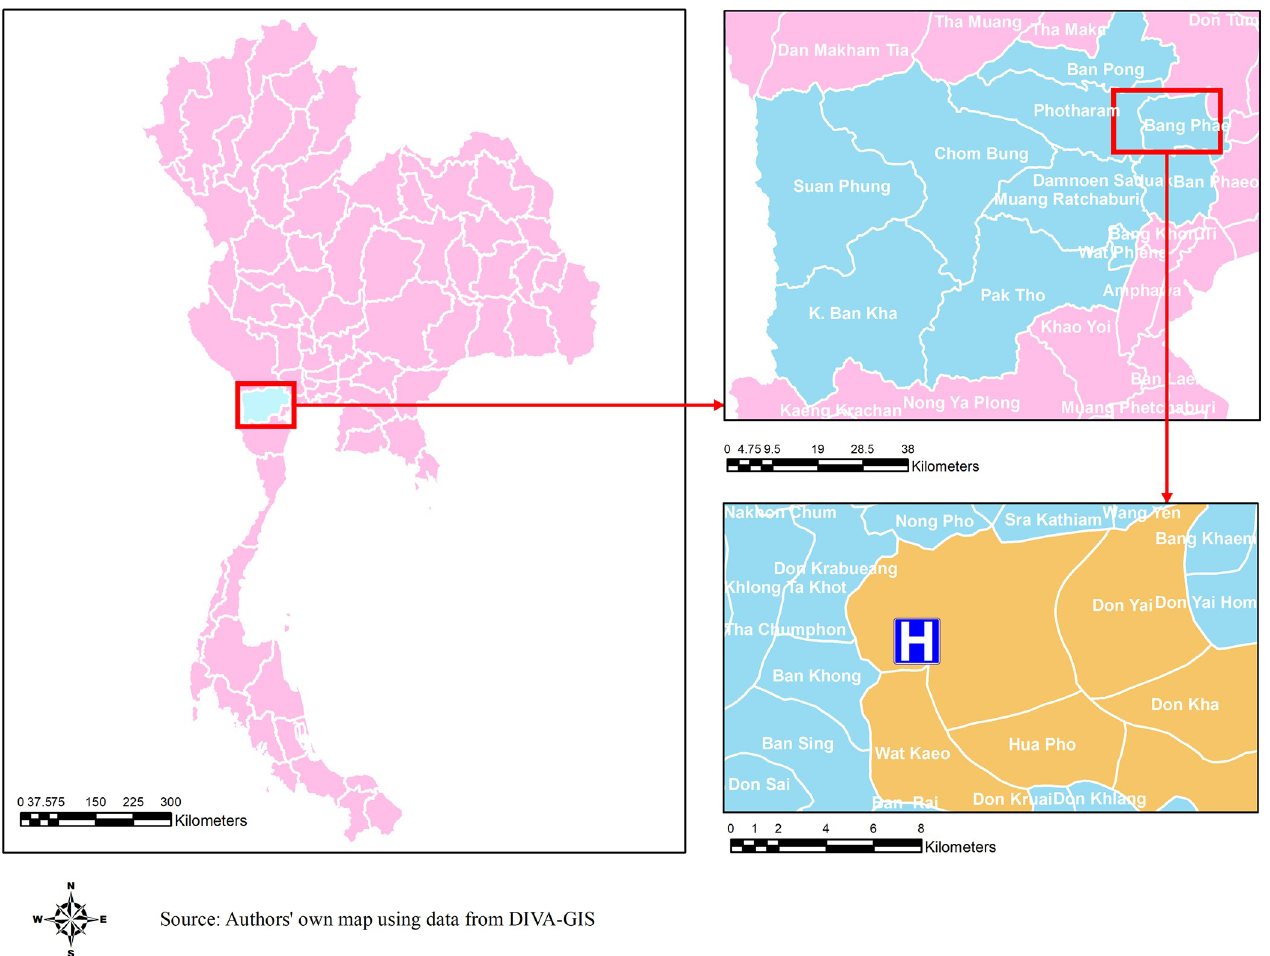
Fig 1. A map of the area of catchment population and study facility in Bang Phae district, Ratchaburi province, Thailand. A map of the study area in Bang Phae district, Ratchaburi province, Thailand. Base layer of the map can be found in https://www.diva-gis.org/gdata.